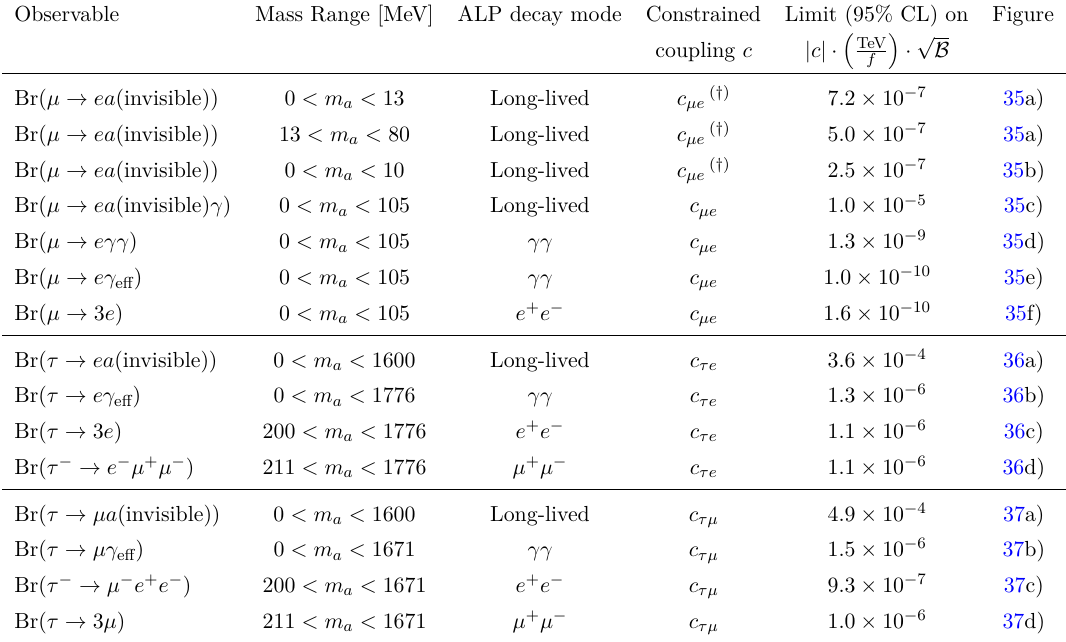
Table 2 . Summary of constraints on the lepton flavor-violating ALP couplings derived from measurements of branching fractions (first column) for various muon and tau decays, in which